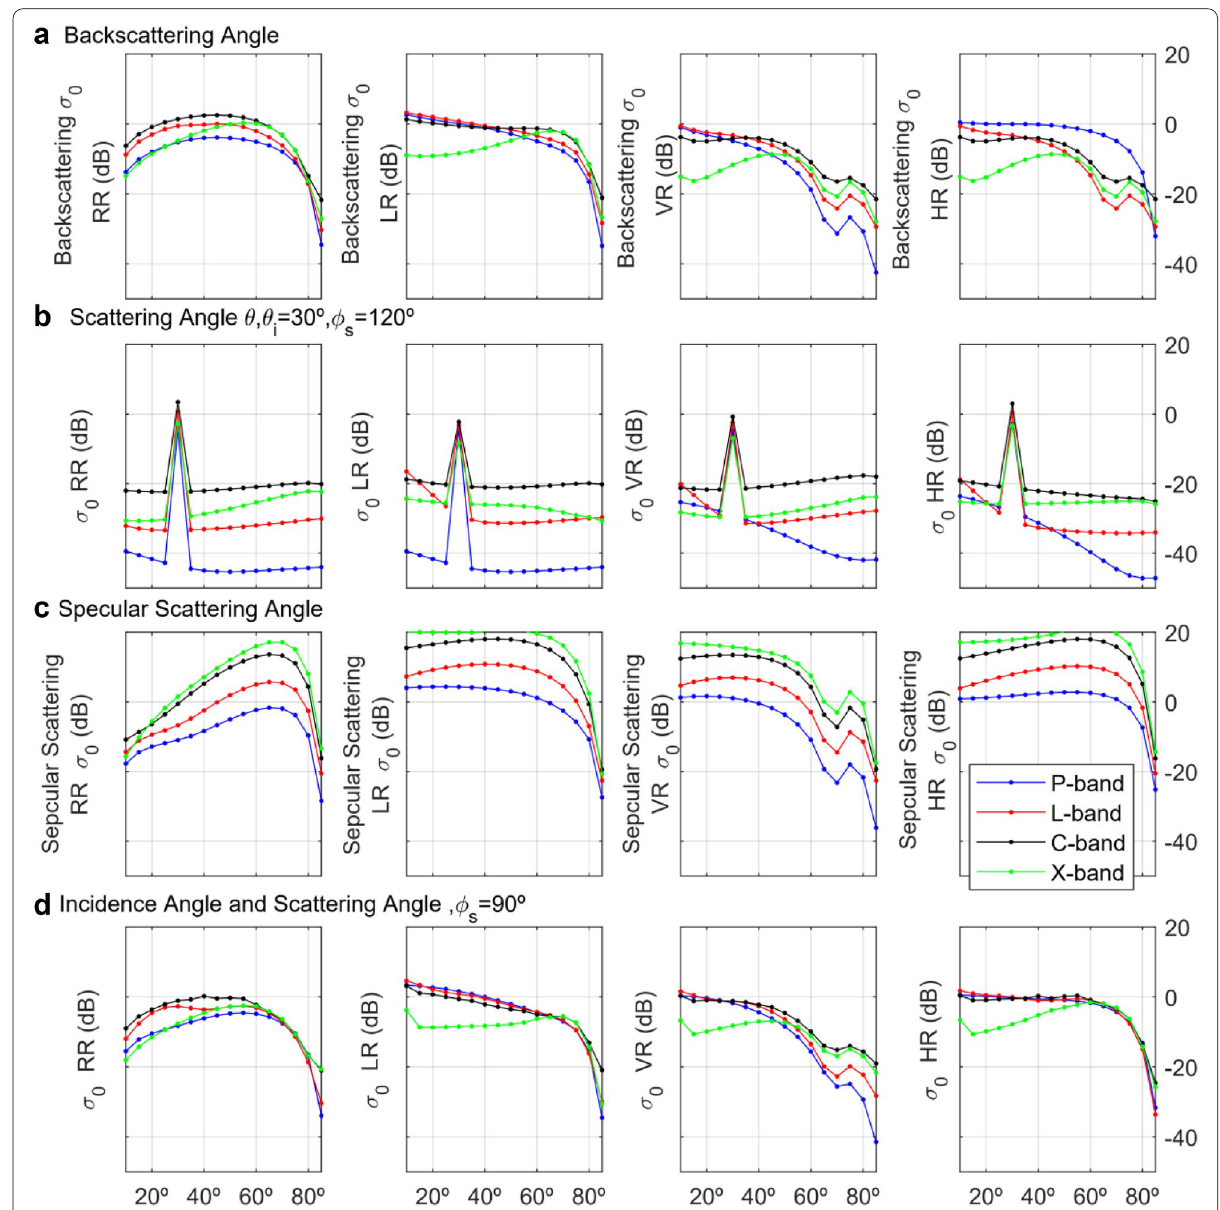
Fig. 4 Canopy bistatic scattering versus scattering angles at P, L, C, and X bands at a backscattering plane, b θ i scattering angle, and d incident and scattering angle,